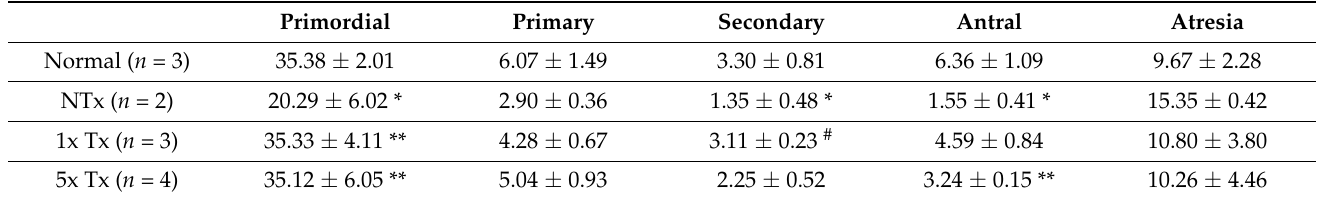
Table 1. Comparison of follicle counts after